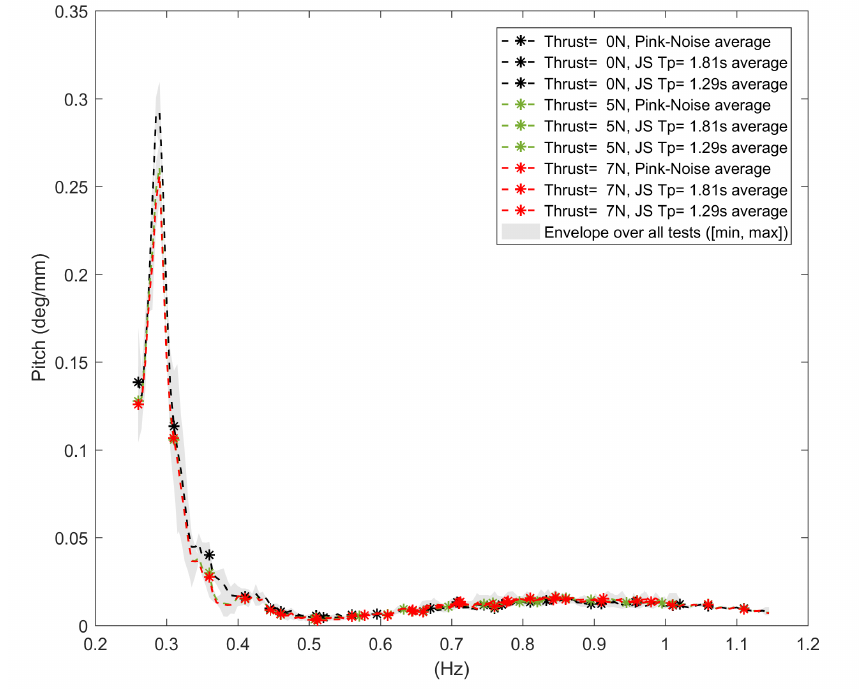
Figure 24. Pitch RAOs for all irregular waves: average and envelop (min and